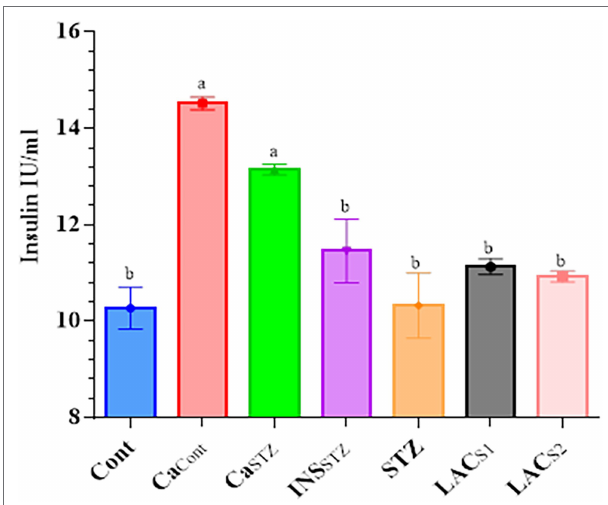
FIGURE 4 | Determination of insulin blood plasma. Cont , control; Ca Cont , camel milk control; Ca STZ , camel milk with streptozotocin; INS STZ , insulin with streptozotocin; STZ , streptozotocin; LAC SI , KLDS 1.0727 with streptozotocin; LAC S2 , KLDS 1.0373 with streptozotocin. Result are given in triplicate as mean ± SD. Different letters indicate significant differences among groups ( p <